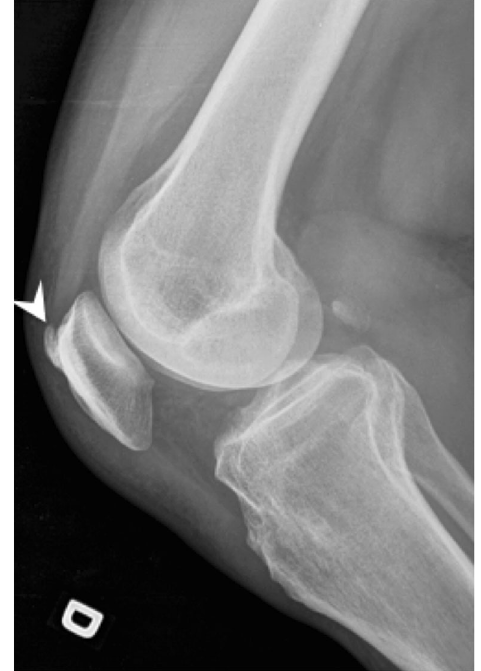
Fig. 8 Enthesophyte. Lateral radiograph of the right knee shows an ossified enthesophyte at the insertion of the quadriceps tendon on the patella